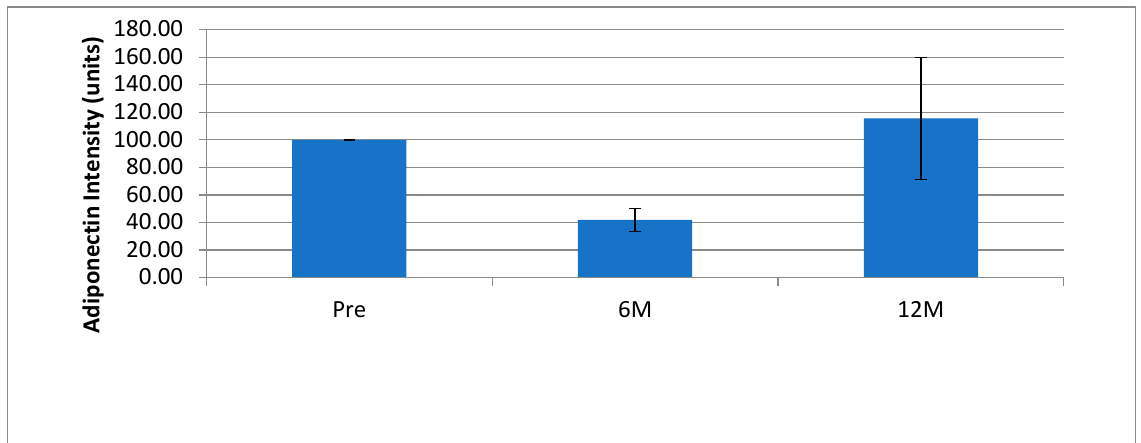
Figure 1. Western blotting of a bariatric patient’s saliva for adiponectin. The numbers correlate with the patient, PS is the pre-Roux-en-Y gastric bypass surgery sample, 6 m is the 6-month follow-up sample, and 12 m is the 12-month follow-up sample.